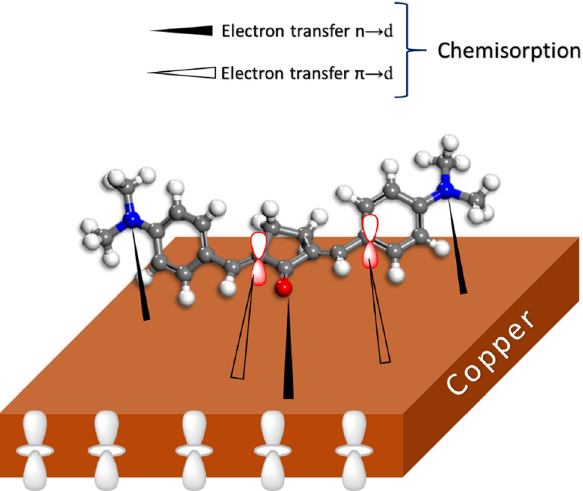
Figure 8: The proposed adsorption mechanism of the M2 inhibitor on the copper